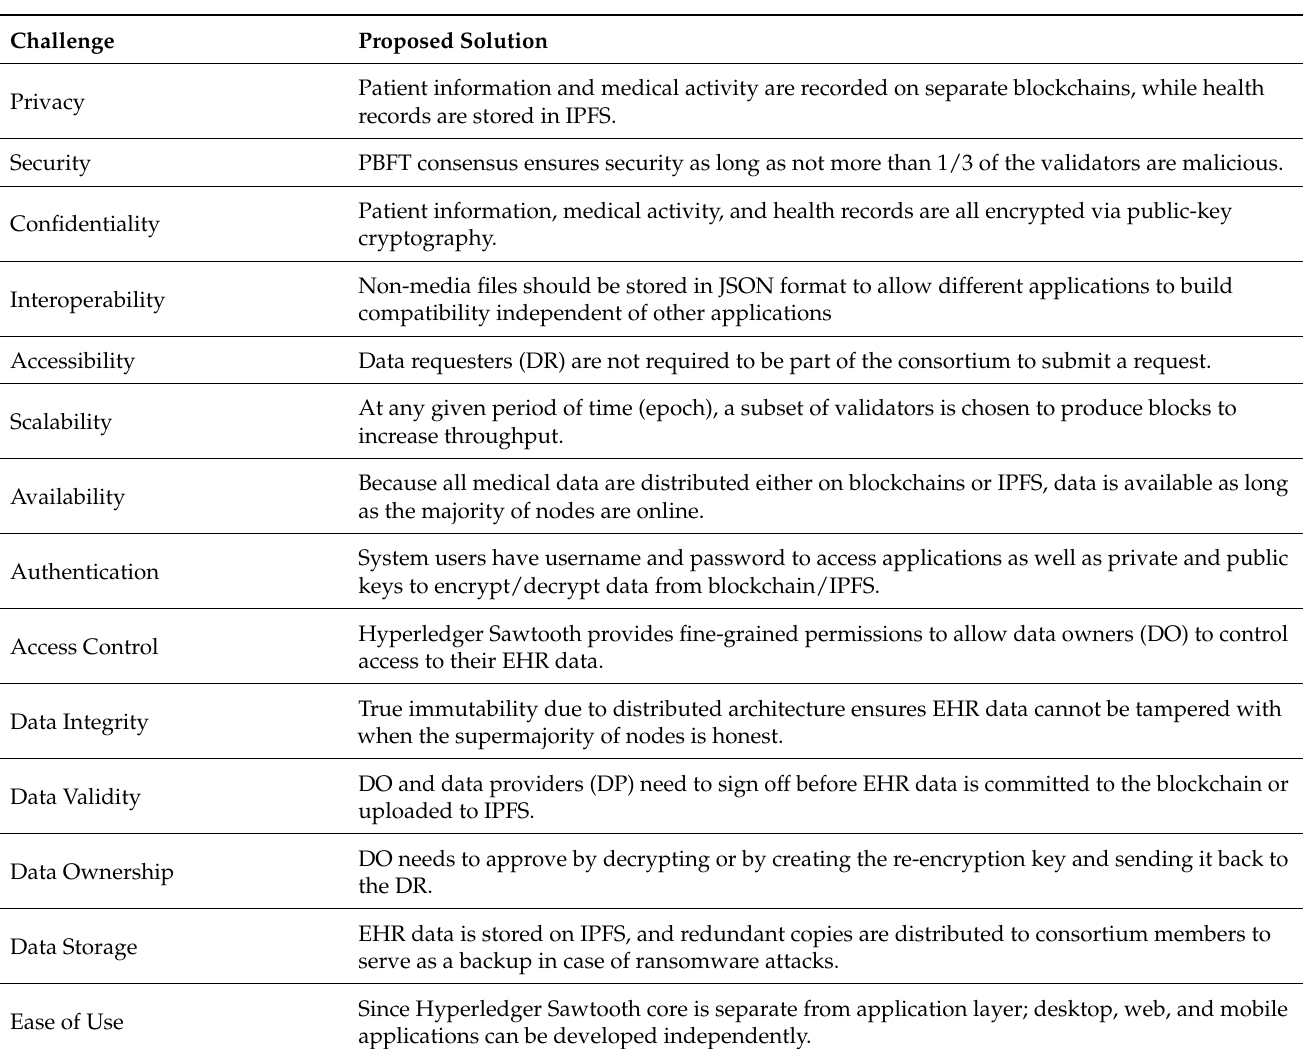
Table 6. How to address all the challenges found in proposed